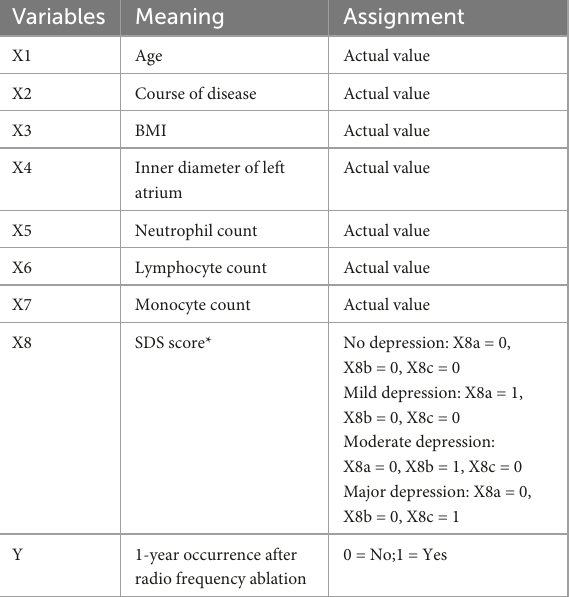
TABLE 3 Each variable and